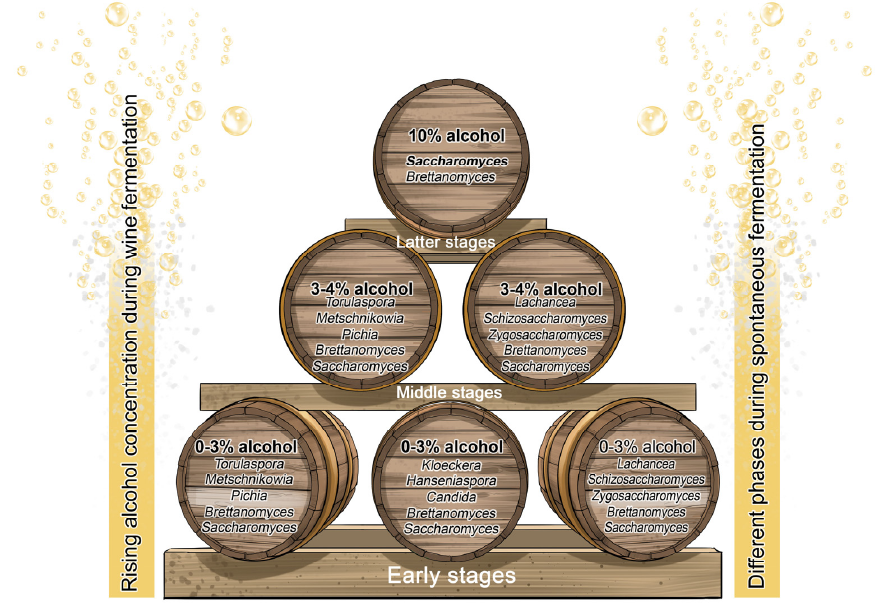
Figure 9. The sequential participation of various yeast species during the fermentation of grape must. The selective pressures prevailing in fermenting grape must (e.g., sugar ‐ induced osmotic pressure), fermentation conditions (e.g., temperature and pH) and winemaking practices (e.g., sulfite additions) inhibit and/or eliminate non ‐ Saccharomyces yeast species during the course of fermentation. The selective nature of grape must becomes more pronounced once anaerobic conditions are established, nutrients become depleted and rising alcohol levels start to constrain the survival of ethanol ‐ sensitive yeasts.